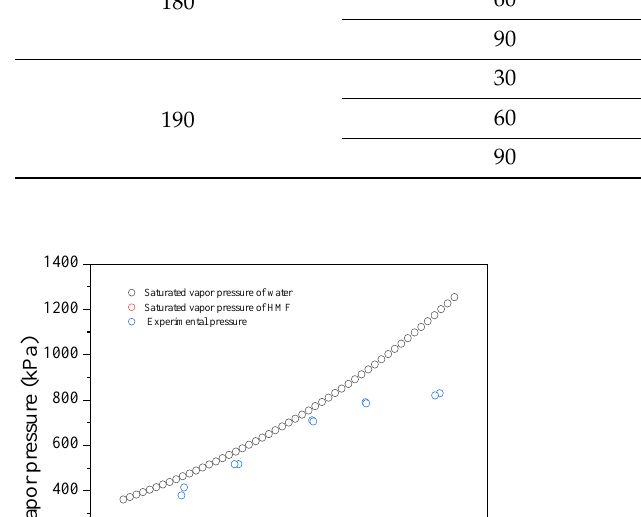
Figure 4. Reaction pathway of glucose.